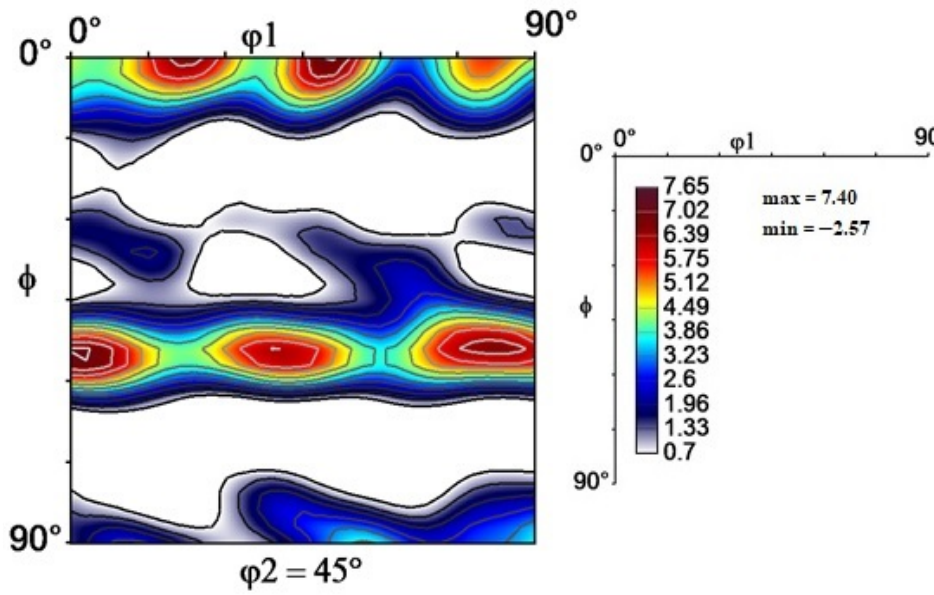
Figure 3. ODF at constant ϕ 2 = 45° of as-received specimen.